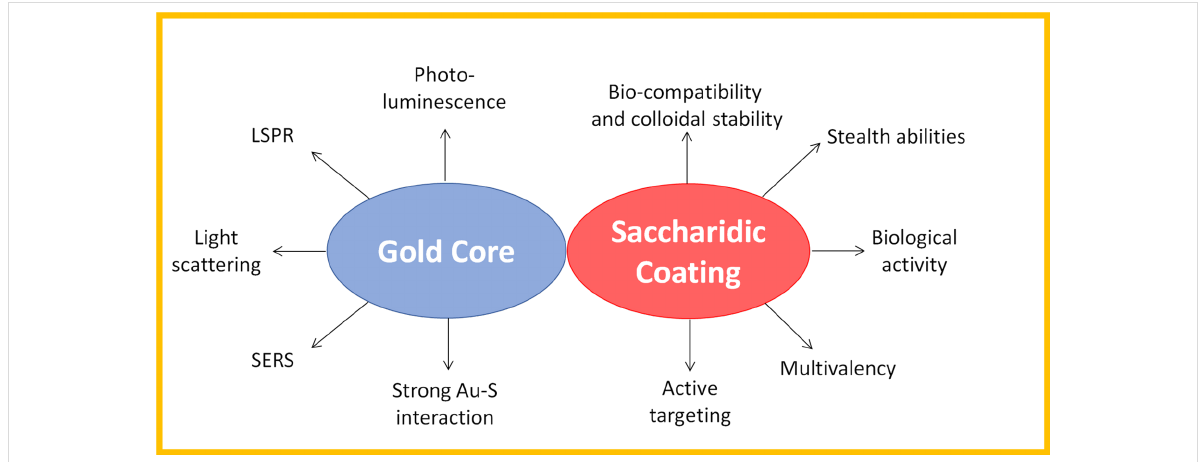
Figure 2: Glyco-gold nanoparticles: metallic core and glyco-coating contribute to the production of the versatile glyco-nanomaterials.